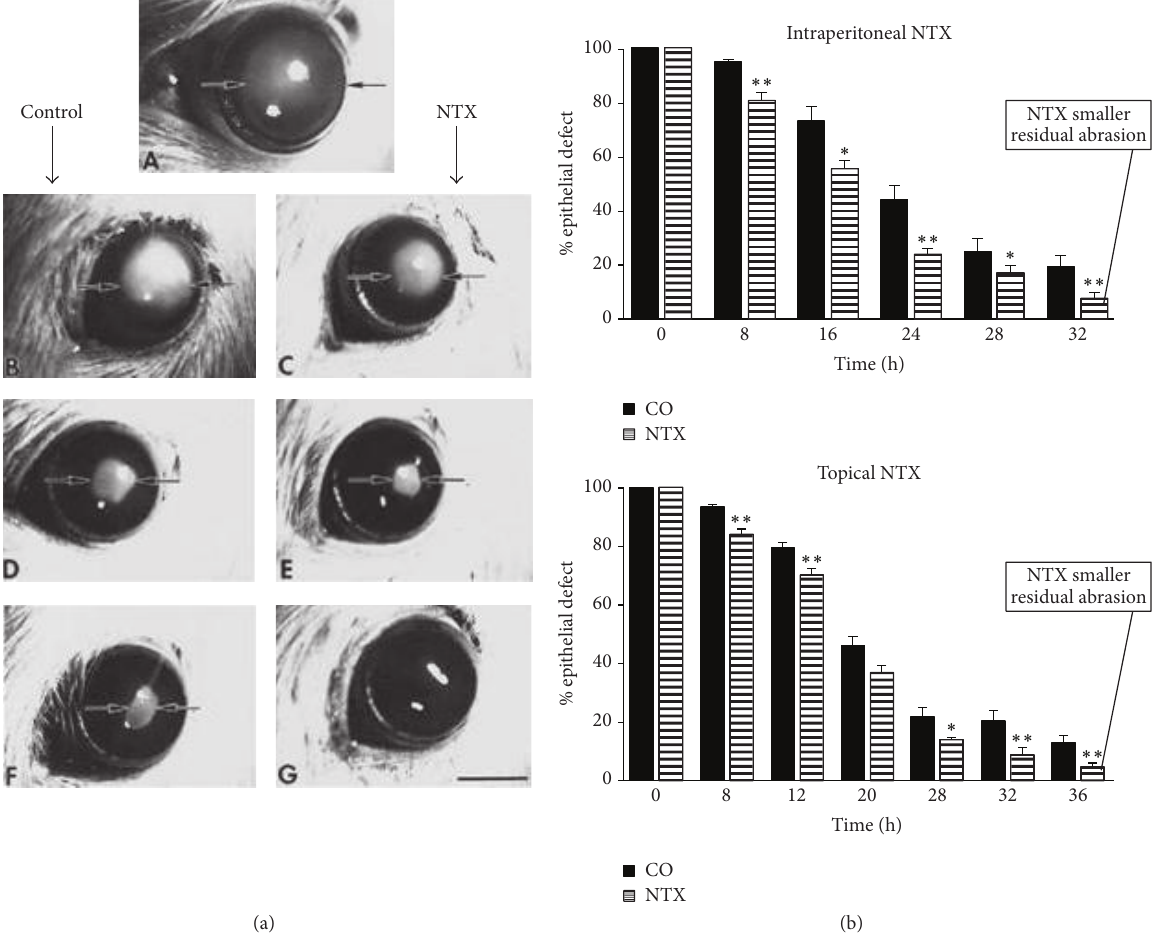
Figure 6: Rat cornea wound healing. (a) Photographs of rat corneas with 4 mm central abrasions stained with fluorescein immediately (A) or at 16 h (B, C), 24 h (D, E), or 32 h (F, G) after wounding and treated either with 30mg/kg intraperitoneal injections of NTX (C, E, G) or with an equivalent volume of vehicle (B, D, F). (b) Histograms illustrate that both intraperitoneal injections of 30 mg/kg NTX or topical 10 −6 M NTX eyedrops four times daily expedite rat corneal epithelial wound healing (derived from [10]). ∗ 𝑃 < 0.05 and ∗∗ 𝑃 < 0.01